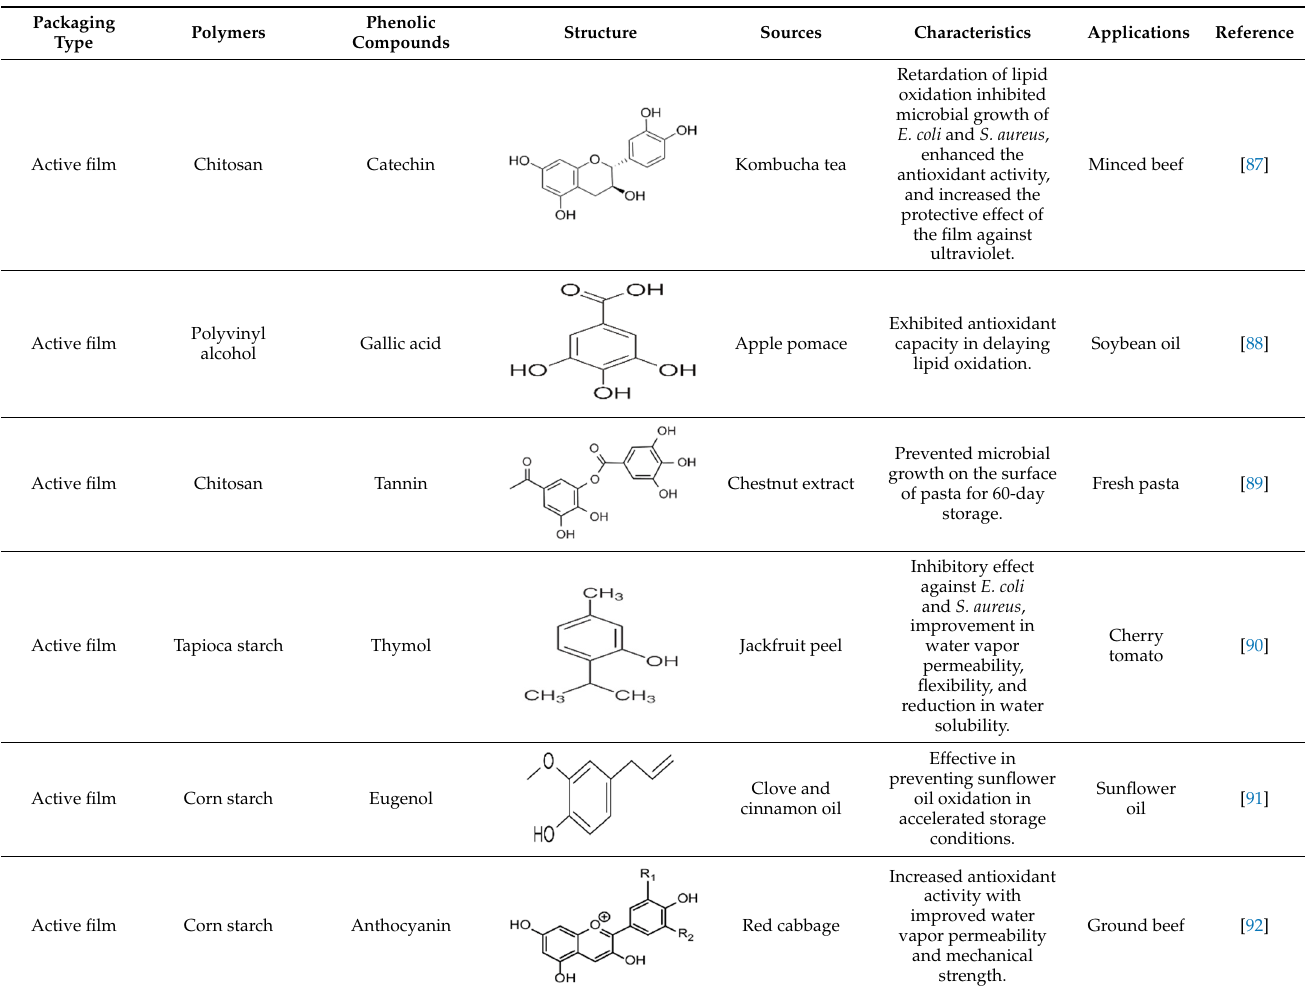
Table 2. Characteristics, and application of active-packaging materials using phenolic compounds from different sources.